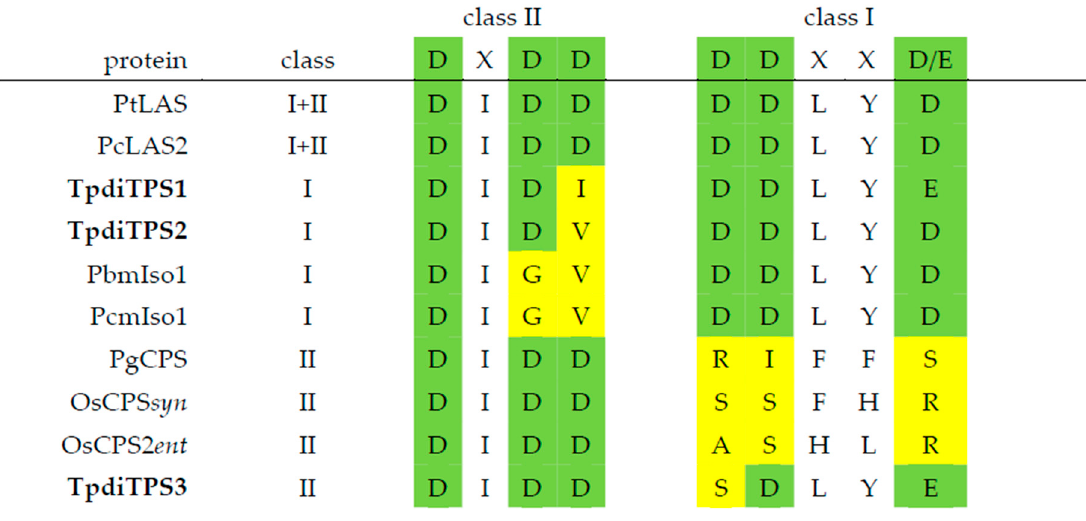
Figure 3. Putative catalytic motifs in TpdiTPS1 and 2 match monofunctional class I proteins and TpdiTPS3 motifs match monofunctional class II proteins. Amino acid alignments of class I and II motifs of Thuja plicata TpdiTPS (1–3) with Pinus taeda bifunctional class I/II levopimaradiene synthase